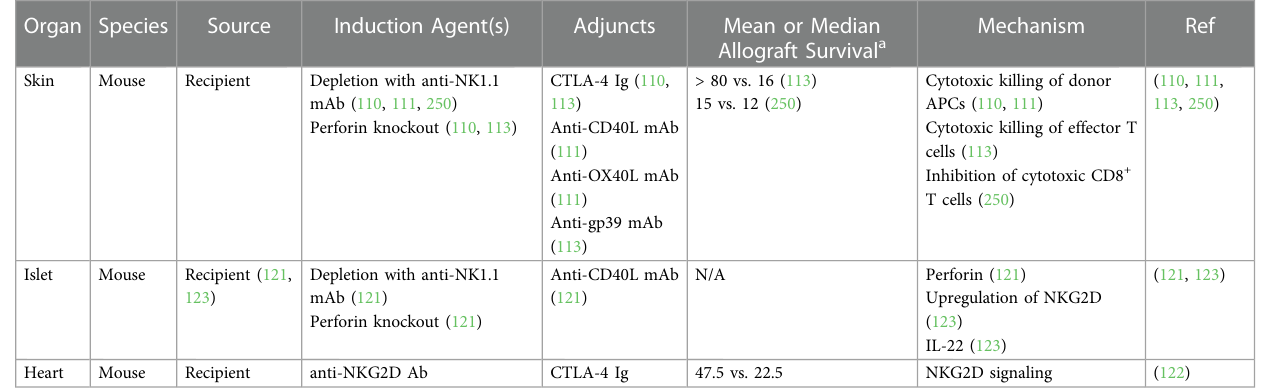
TABLE 4 Studies of NK cells in animal